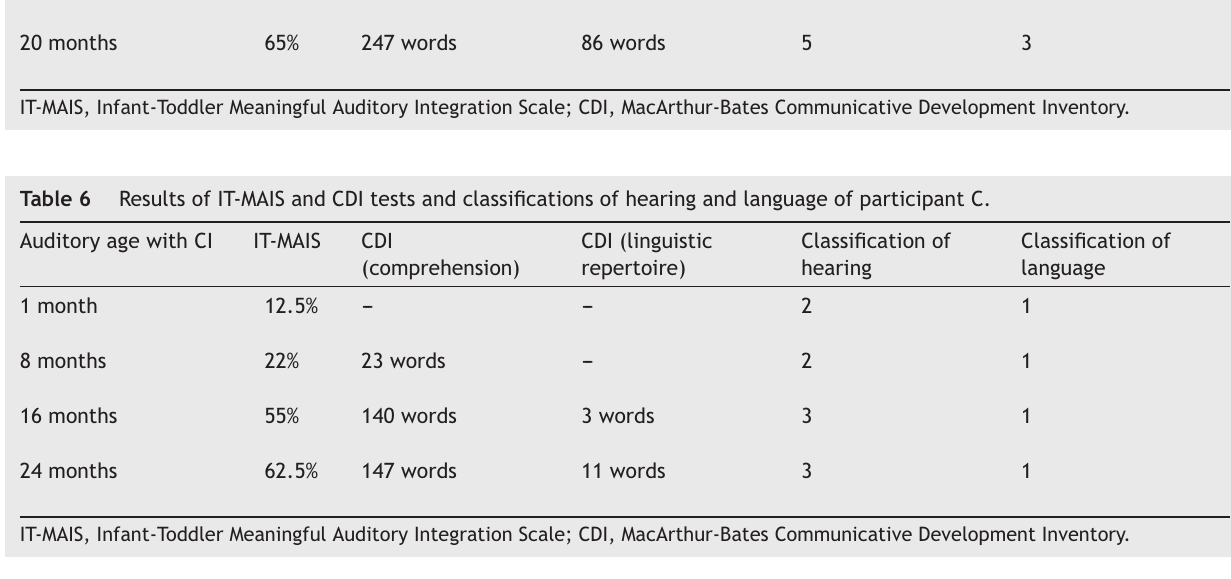
IT-MAIS, Infant-Toddler Meaningful Auditory Integration Scale; CDI, MacArthur-Bates Communicative Development Inventory.